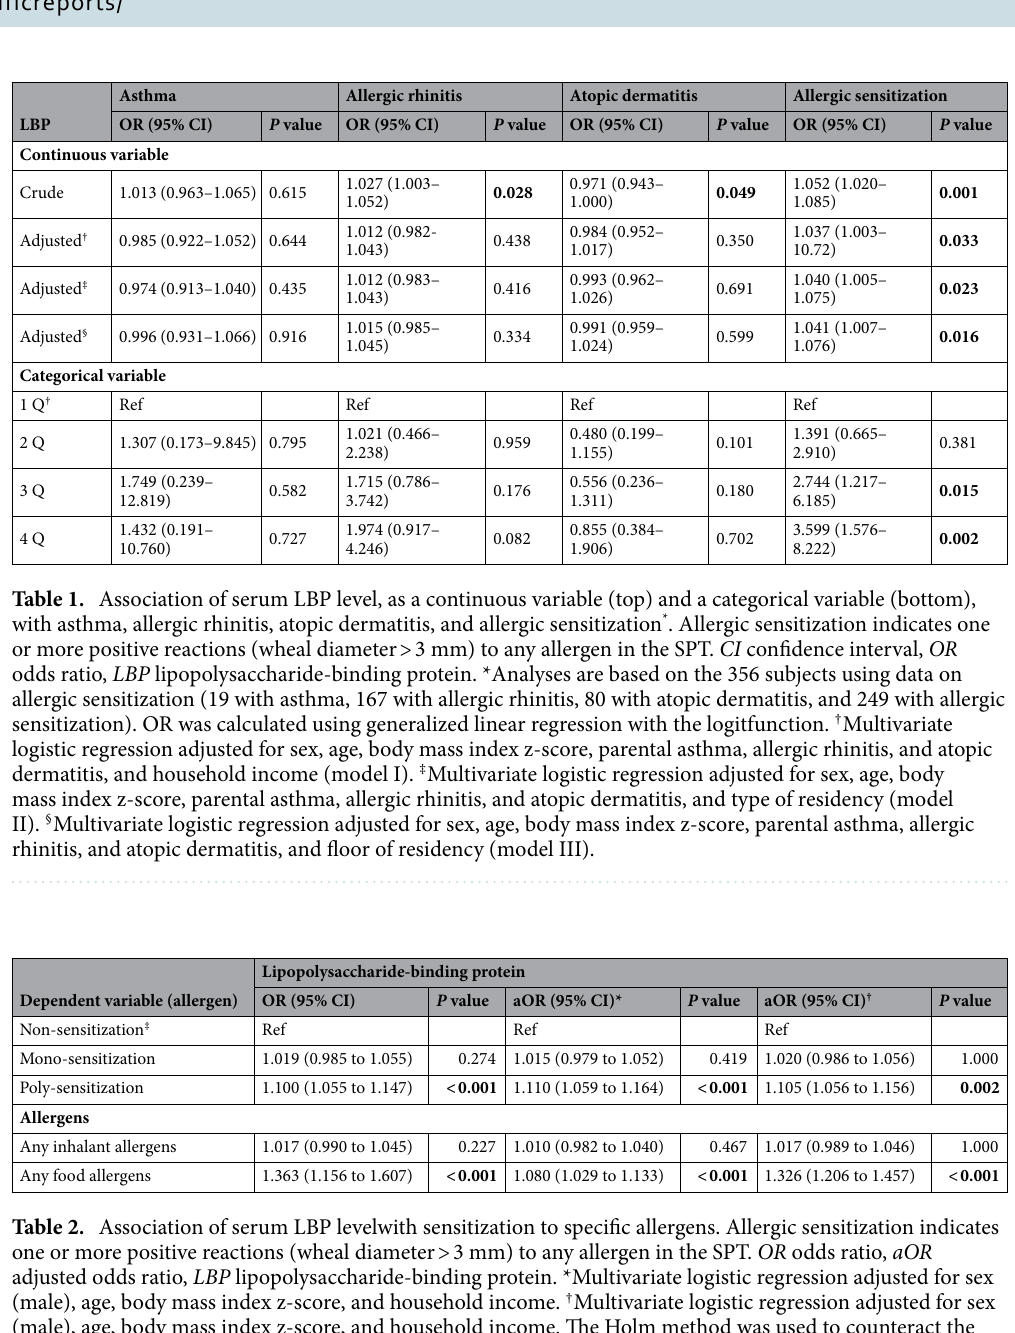
adjustment for sex and age are shown in Suppl Table 3: Japanese hop, apple, peach, kiwi, orange, tomato, celery, peanut, walnut, wheat, egg, milk, mussel, and shrimp showed a significant positive correlation with LBP level.